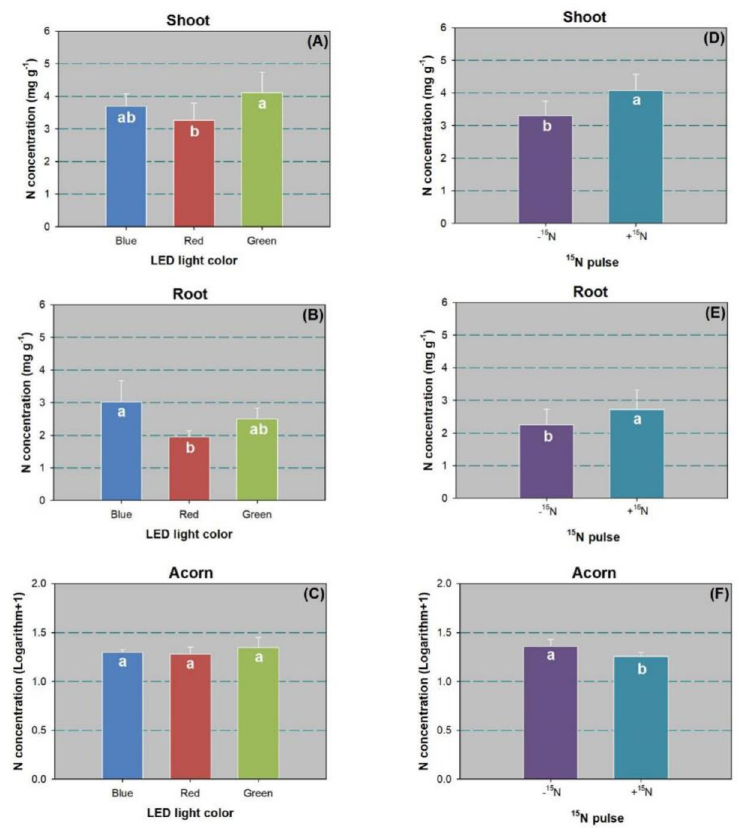
Fig 5. Nitrogen (N) concentration in shoot (A,D), root (B,E), and acorn (C,F) of Chinese cork oak ( Quercus variabilis Blume) seedlings subjected to blue, red, and green colors of LED spectra ( n = 24) or subjected to N pulse at 120 mg 15 N plant -1 (+ 15 N) or zero (- 15 N) ( n = 36). Columns and bars represent means and standard errors, respectively. Different letters denote a significant difference according to Tukey’s test at the 0.05